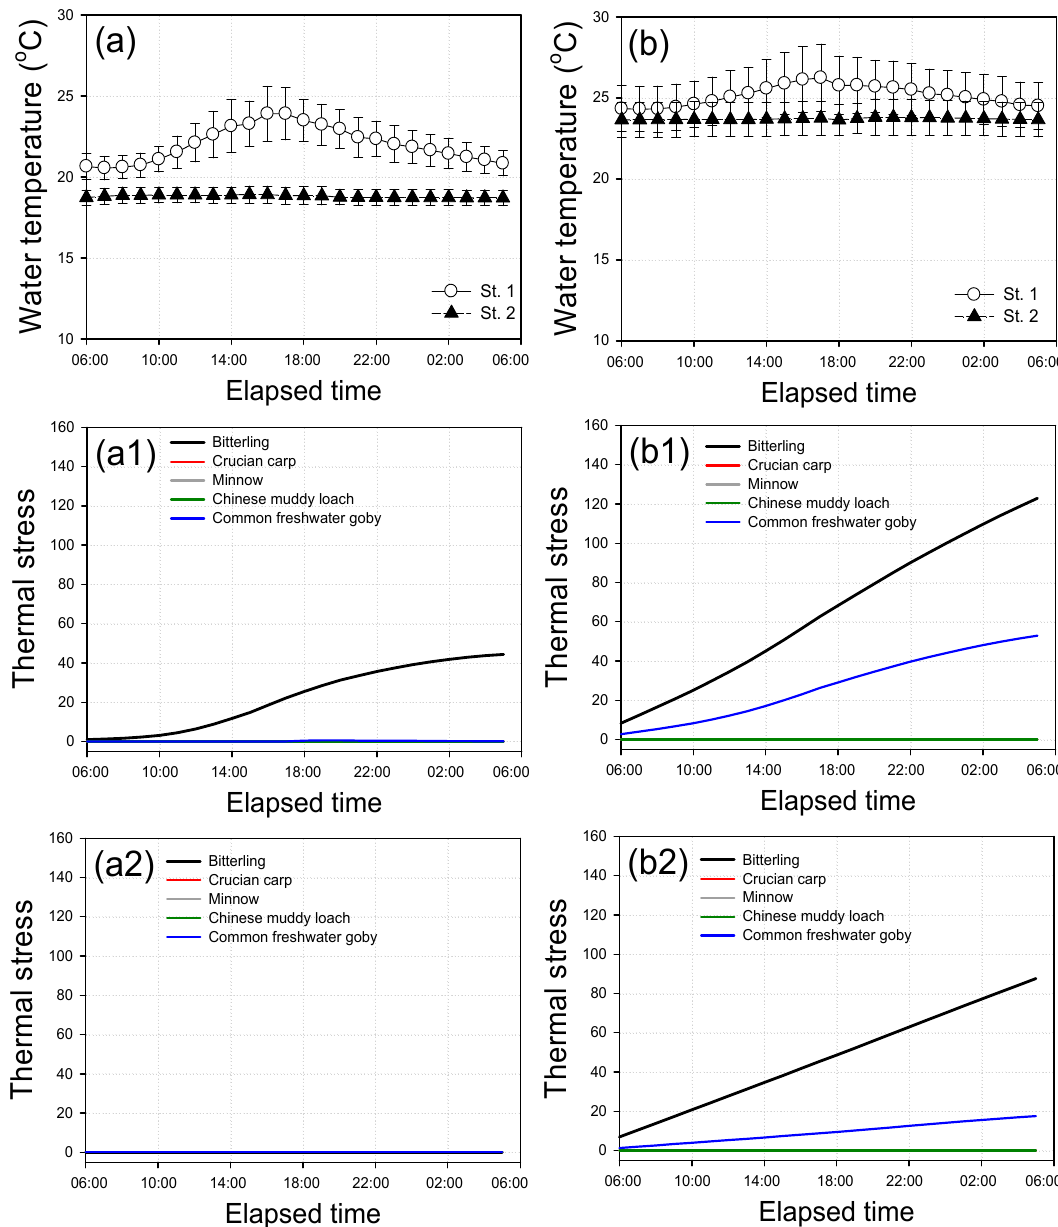
Figure 6. Diurnal variations in the average water temperature and thermal stress for the fish fauna inhabiting the study site in 2012. ( a ) Normal season. ( b ) Rainy season. ( a1 ) Thermal stress for various fish fauna in St. 1 in the normal season. ( a2 ) Thermal stress for various fish fauna in St. 2 in the normal season. ( b1 ) Thermal stress for various fish fauna in St. 1 in the rainy season. ( b2 ) Thermal stress for various fish fauna in St. 2 in the rainy season. Crucian carp and minnow showed ND.